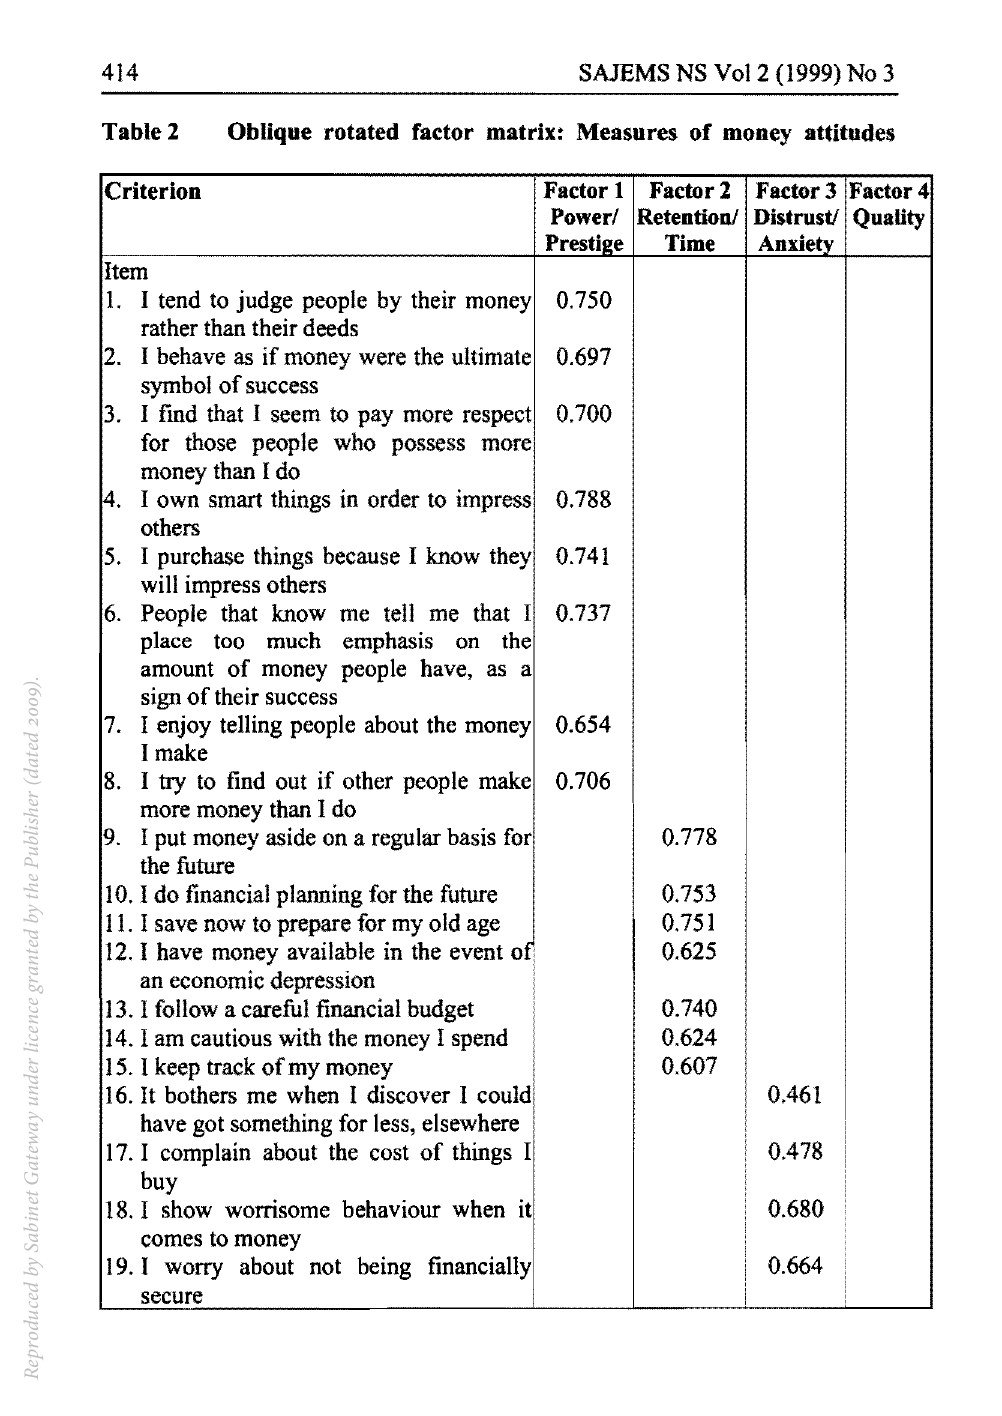
Oblique rotated factor matrix: Measures of money attitudes